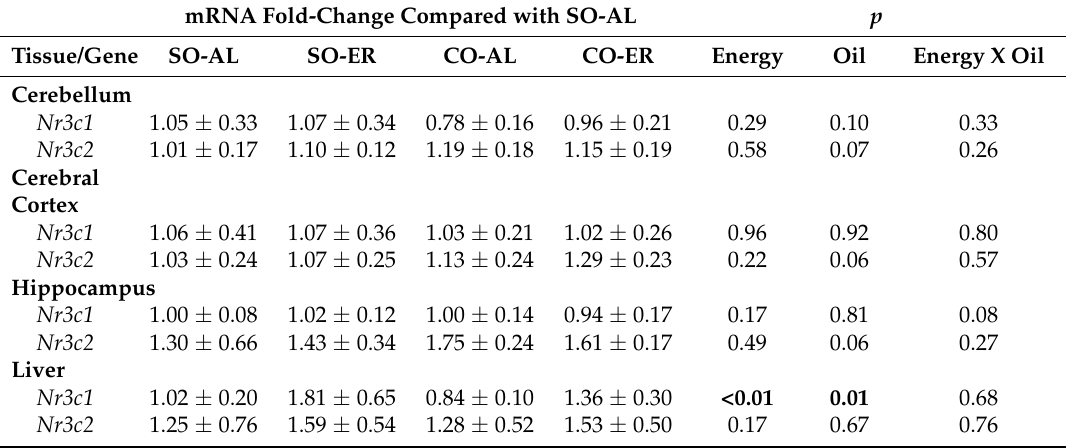
Table 8. Tissue expression of glucocorticoid and mineralocorticoid receptor mRNA. mRNA Fold-Change Compared with